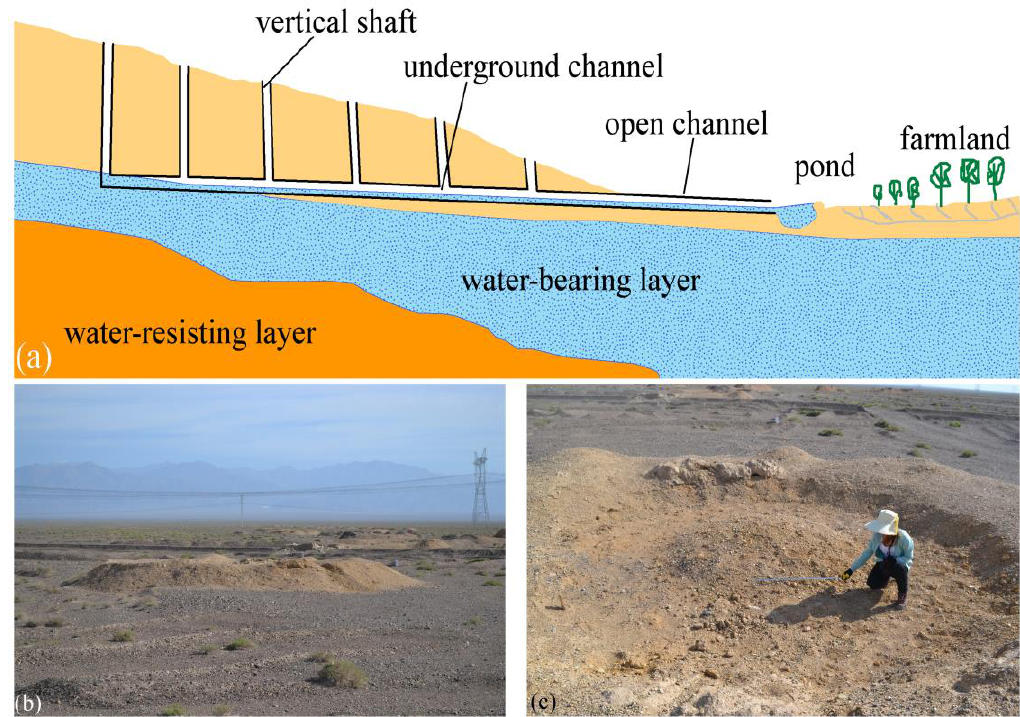
Figure 2. ( a ) Schematic view of a typical qanat system. ( b ) and ( c ) are photos of